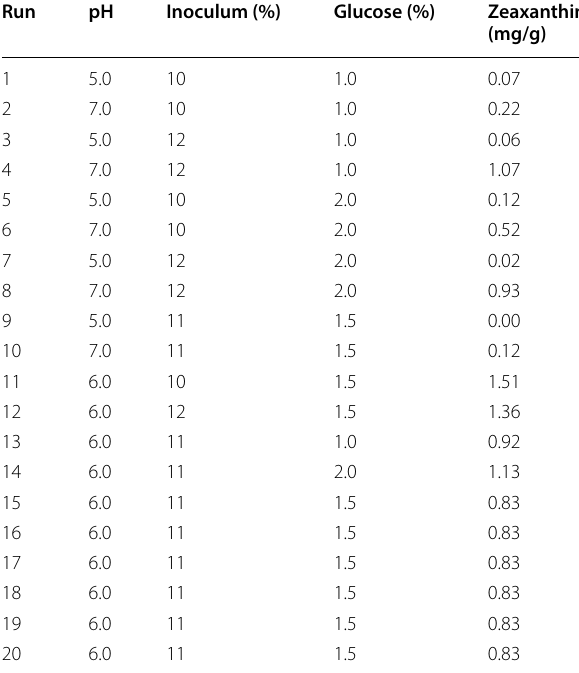
Table 2 CCD matrix showing the zeaxanthin yield on 3rd day, agitation at 120 rpm and 40 °C using A.